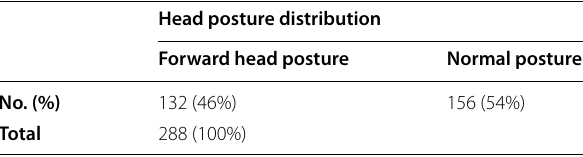
Table 2 The frequency distribution of head posture in the study group